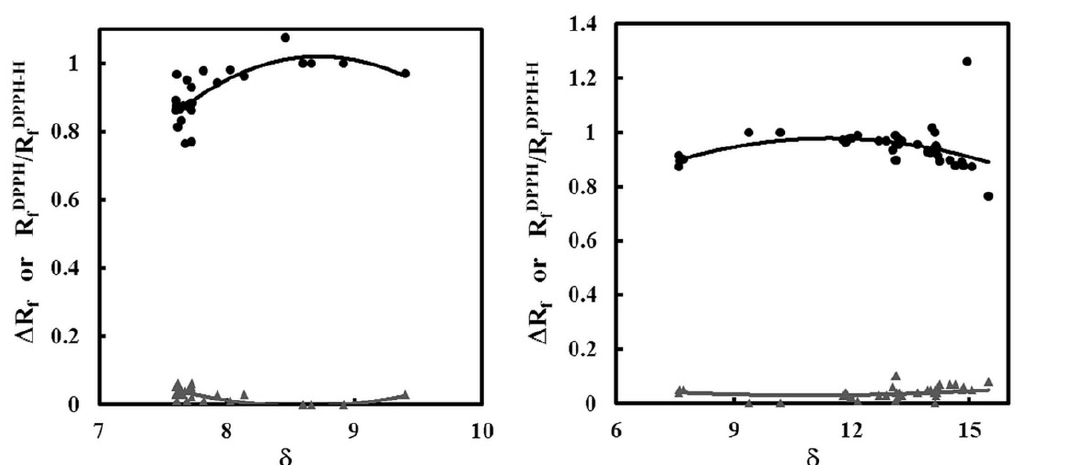
Figure 3: Dependence of the ratio (●, black line) and the difference ( Chromatographic conditions: NP plate (left picture), RP (right), temp. +20 ○ C, saturated chamber.